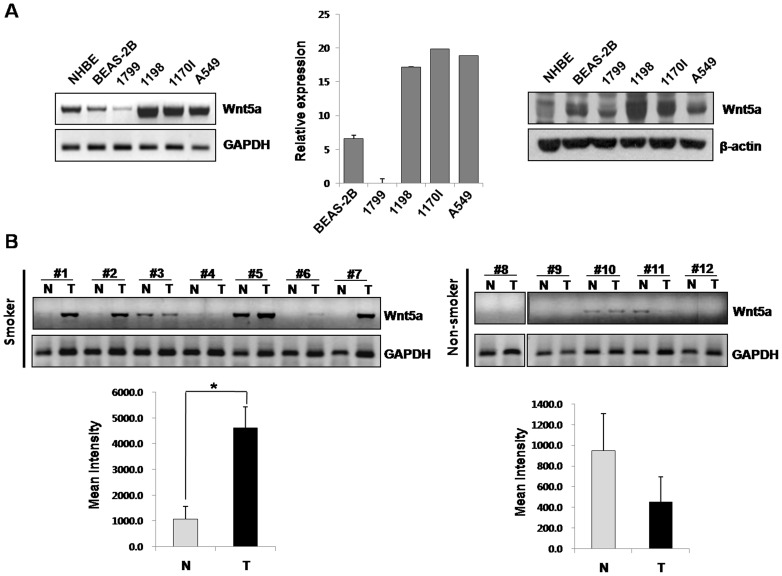
Expression of Wnt5a gene in HBE cells and normal matched lung tissues. (A) mRNA and protein levels of Wnt5a expression were evaluated by RT-PCR (left), quantitative RT-PCR (middle) and Western blot analysis (right) in lung carcinogenesis in five HBE cells (NHBE, BEAS-2B, 1179, 1198 and 1170I) with different cell phenotype by exposure to cigarette smoke condensates. (B) mRNA levels of Wnt5a in 12 normal matched lung tumor tissues (7 smokers and 5 non-smokers) by RT-PCR. N: normal tissue, T: tumor tissue. Quantification of data means the average intensity of Wnt5a bands normalized by GAPDH. Bars denote standard error. Significant differences (*: p<0.03) from normal tissues as determined by a Student's t test.